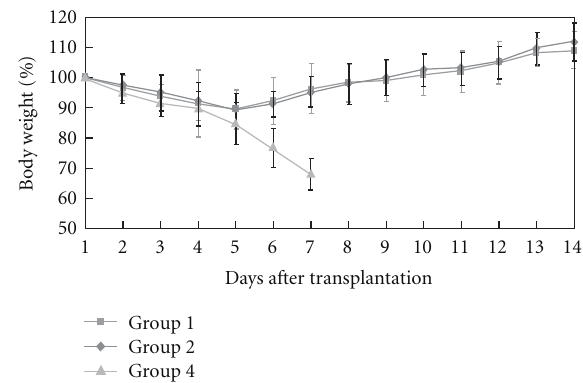
Figure 1: Postoperative body weight curves following liver trans- plantation. In group 1 and 2, all recipients lost body weight shortly after transplantation but regained weight and grew well